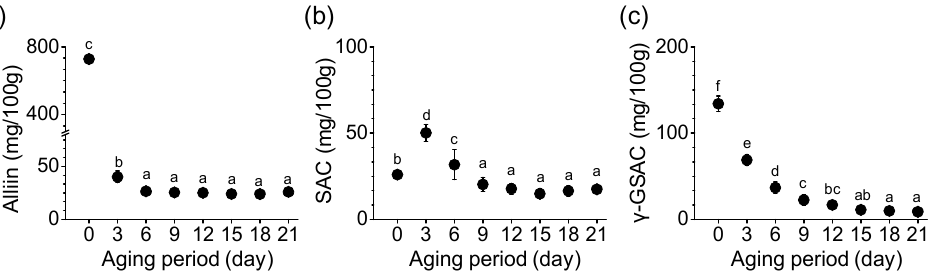
Figure 3. Changes in ( a ) alliin, ( b ) SAC, and ( c ) γ -GSAC content during the aging of SRG. Each point represents the mean ± SD (n = 6). Different letters indicate significant differences between the same sample based on Duncan’s multiple range test ( p < 0.05).